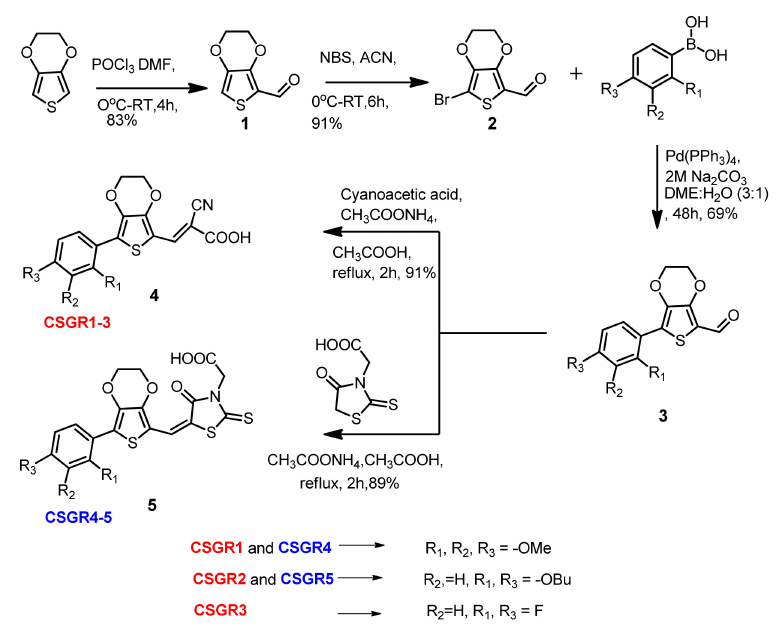
Figure 2. Synthesis of CSGR1-5